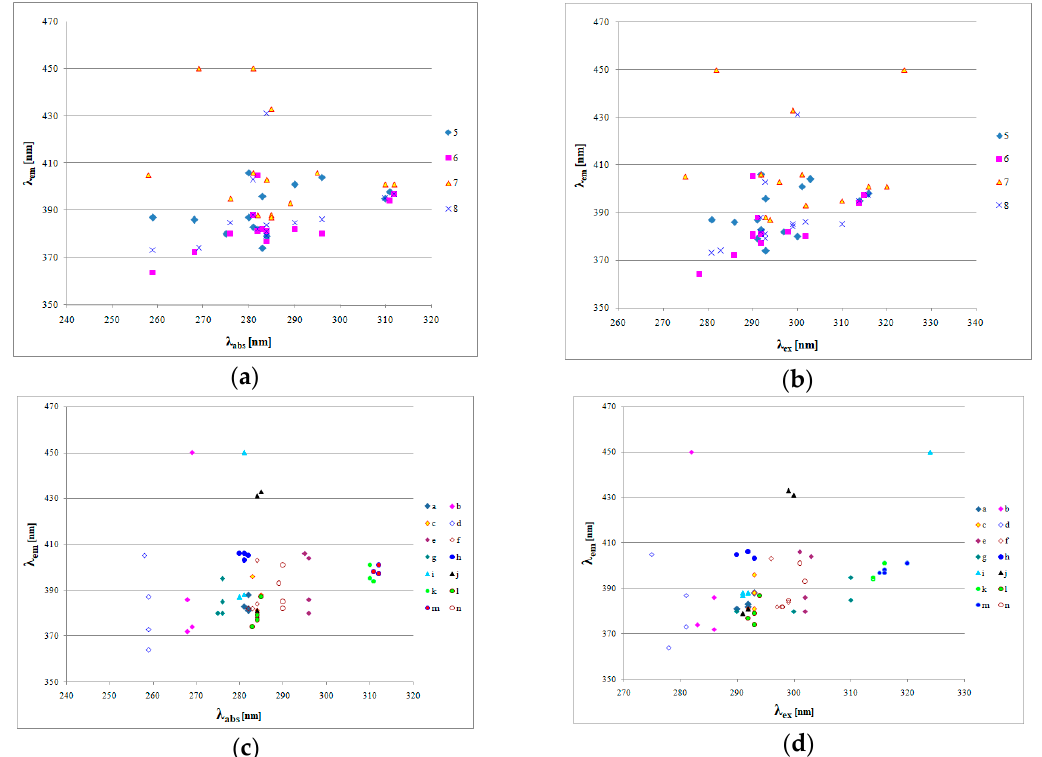
Figure 2. Absorption-emission or excitation-emission maxima of studied compounds: ( a ) Absorption- emission maxima of studied compounds containing ethyl ( 5a–n ), propyl ( 6a–n ), butyl ( 7a–n ) and hexyl ( 8a–n ) substituents; ( b ) excitation-emission maxima of studied compounds containing ethyl ( 5a–n ), propyl ( 6a–n ), butyl ( 7a–n ) and hexyl ( 8a–n ) substituents; ( c ) absorption-emission maxima of studied compounds containing different aryl substituents; ( d ) excitation-emission maxima of studied compounds containing different aryl substituents.